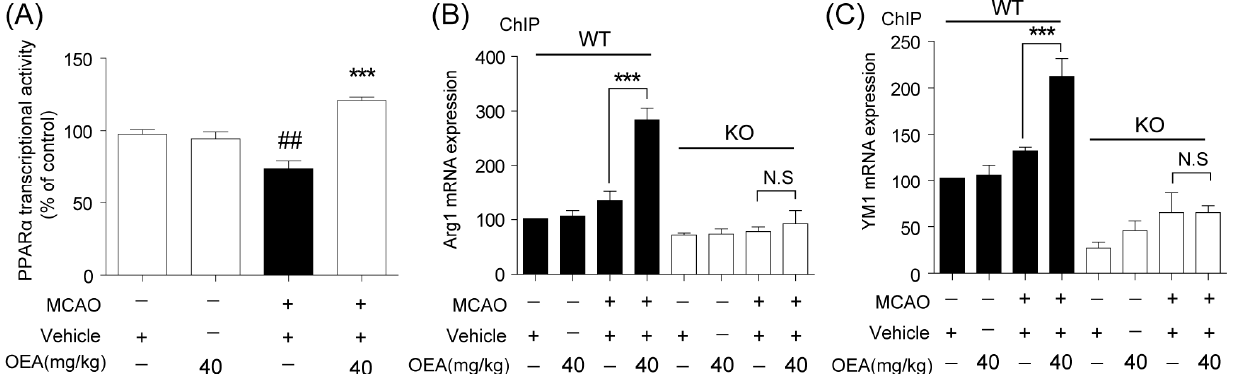
Figure 4. The activation of PPAR α by OEA transcriptionally modulates Arg1 and Ym1 expression in WT mice cortex after MCAO. ( A ) The activation of PPAR α was analyzed by EMSA at 24 h after MCAO. ( B , C ) The binding activity of PPAR α with the Arg1 and YM1 promoters after MCAO was detected using a ChIP assay with a PPAR α antibody at 24 after MCAO. The data are the means ± SEM. n = 5 per group. ## p < 0.01 vs. vehicle + sham group, *** p < 0.001 vs. vehicle + MCAO group; N.S = No Signi fi cance.